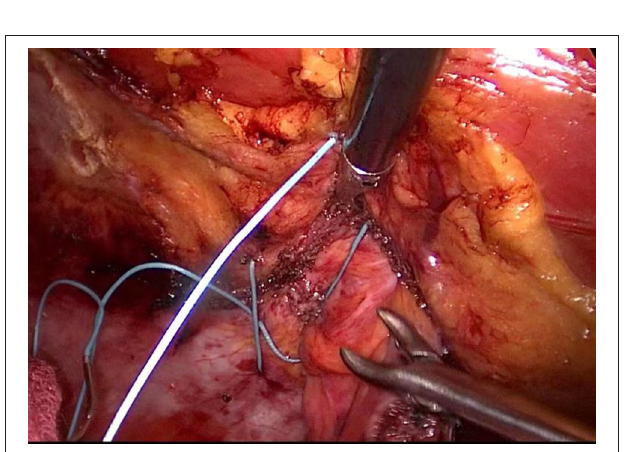
FIGURE 5 | Mesh placement.